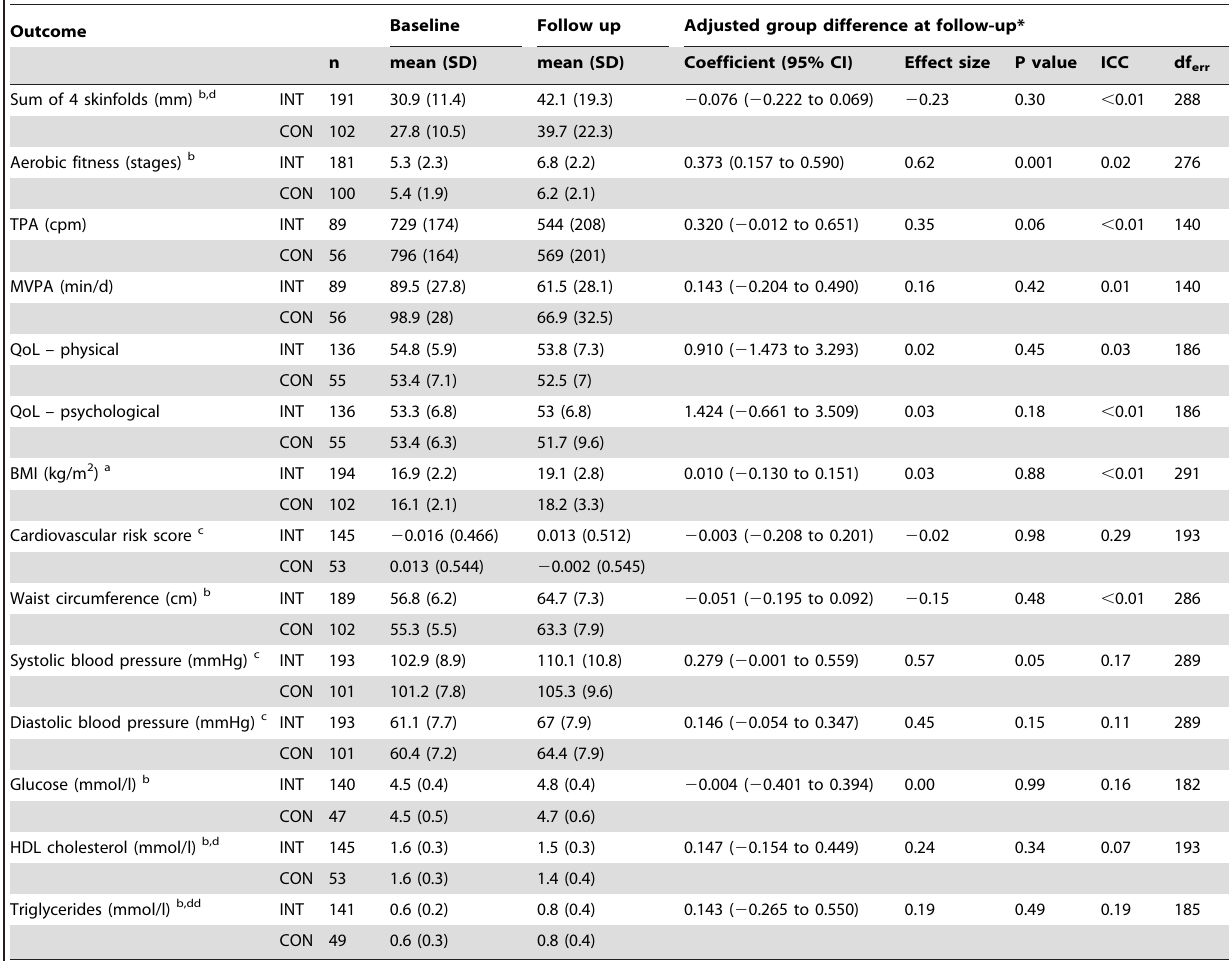
*Differences in average change and 95% confidence intervals (CI) are the differences between intervention (INT) and controls (CON) after adjustment by mixed-model regression analysis for grade, gender, baseline value of the outcome and cluster (class). TPA=total physical activity; cpm=counts per minute; MVPA=moderate and vigorous physical activity, QoL=Quality of Life; BMI=body mass index; HDL=high-density lipoprotein; ICC=intracluster correlation coefficient; df err =error degrees of freedom. Z-Scores are based on a WHO references, b internal